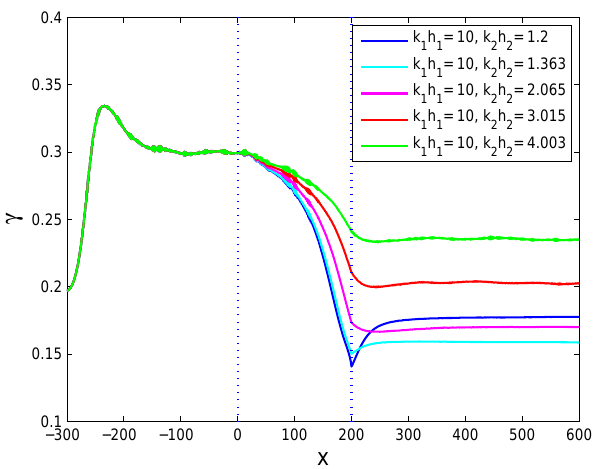
Fig. 11. Skewness as a function of x for k 1 h 1 = 10, k 2 h 2 = 1.2, 1.363, 2.065, 3.015, 4.003 and initial BFI = 0 . 5. for a sloping bottom, and with the same initial BFI for in- coming waves, the stabilized kurtosis after a sloping bottom is smaller than for a flat bottom when k 2 h 2 > 1 . 363, larger when k 2 h 2 < 1 . 363 and the same when k 2 h 2 = 1 .